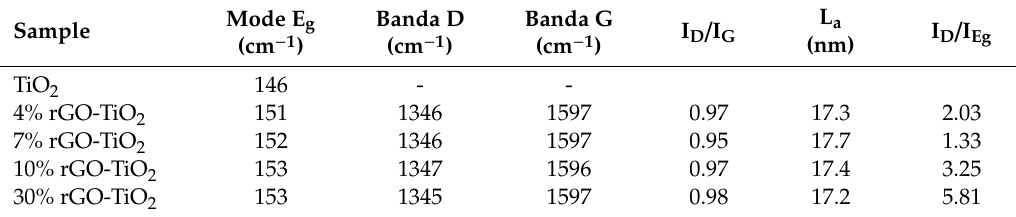
Table 5. Parameters obtained from Raman spectra for TiO 2 and xrGO-TiO 2